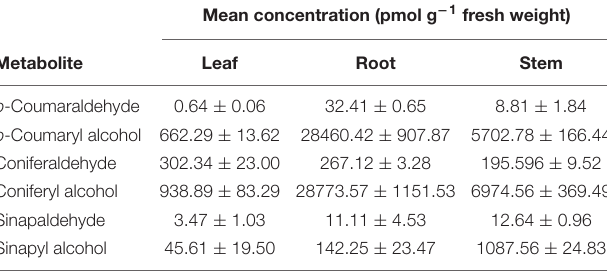
TABLE 1 | Monolignol metabolite contents in various Arabidopsis